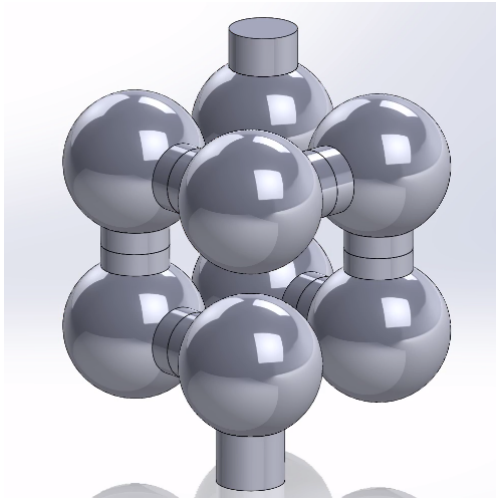
Figure 3. Labyrinthine